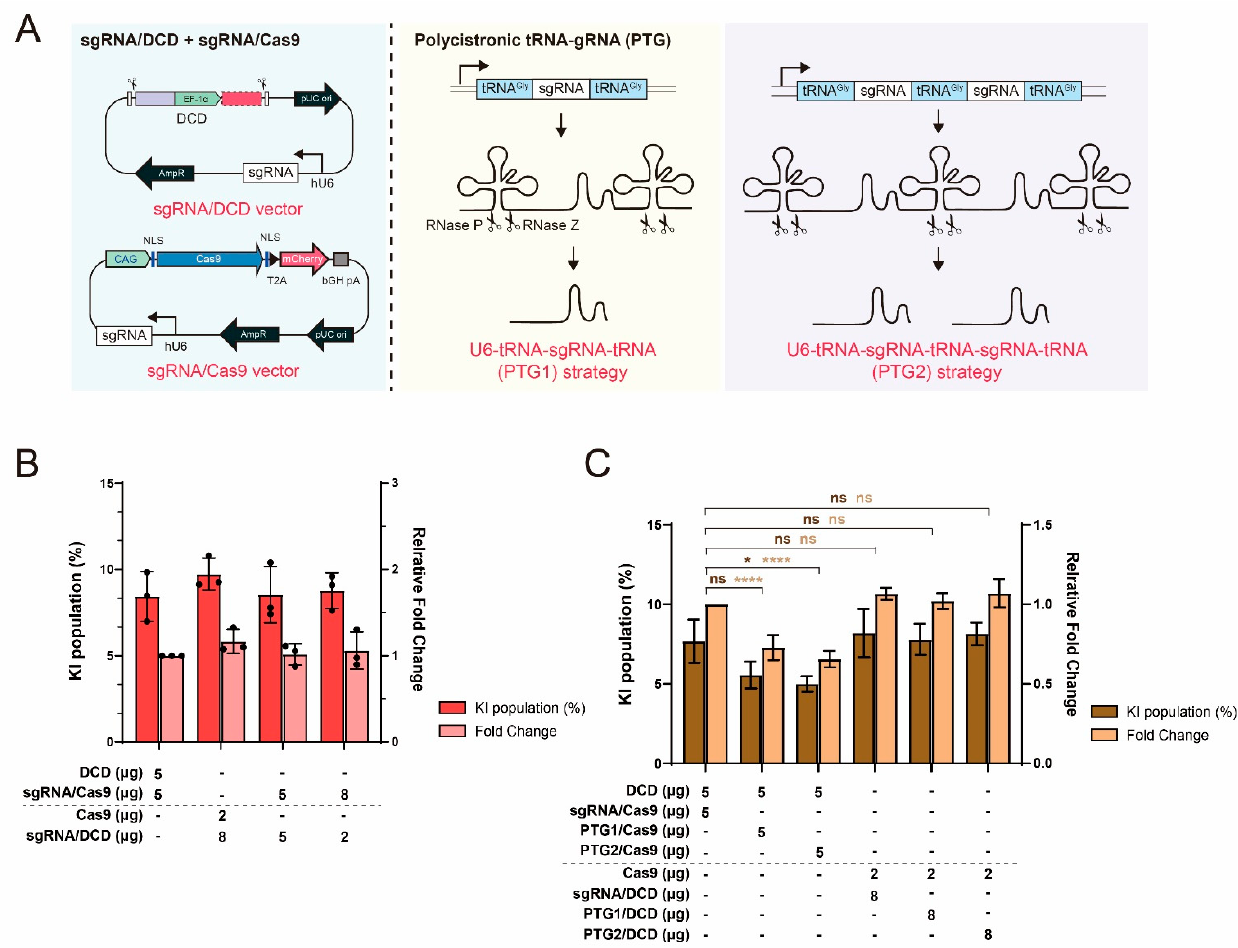
Figure 3. Limited effect of sgRNA supplementation on knock-in (KI) efficiency. ( A ) Schematic diagram of vector constructs needed for sgRNA supplementation. To increase the component number of sgRNA, the sgRNA/DCD plasmid in the multi-component (MC) system and sgRNA/Cas9 plasmid in the DCD system were introduced together, or synthetic polycistronic–tRNA–gRNA (PTG) genes consisting of tandemly arrayed tRNA–gRNA units were inserted into the sgRNA expression cassettes downstream of the U6 promoter. ( B ) The combined use of the MC and DCD systems. The sgRNA/DCD and sgRNA/Cas9 vectors used in the MC and DCD systems, respectively, were transfected at a ratio of 5:5 ( w / w ) or 8:2 ( w / w ). The previous DCD (5:5, w / w ) and optimized MC (8:2, w / w ) were also tested to assess the effect of their combined use on KI efficiency. By the statistical analysis, these results are indicated as non-significant. ( C ) Application of the PTG system to the DCD and MC systems. The error bars represent the mean ± standard deviation from three independent experiments. * p ≤ 0.05, **** p ≤ 0.0001; ns, not significant.